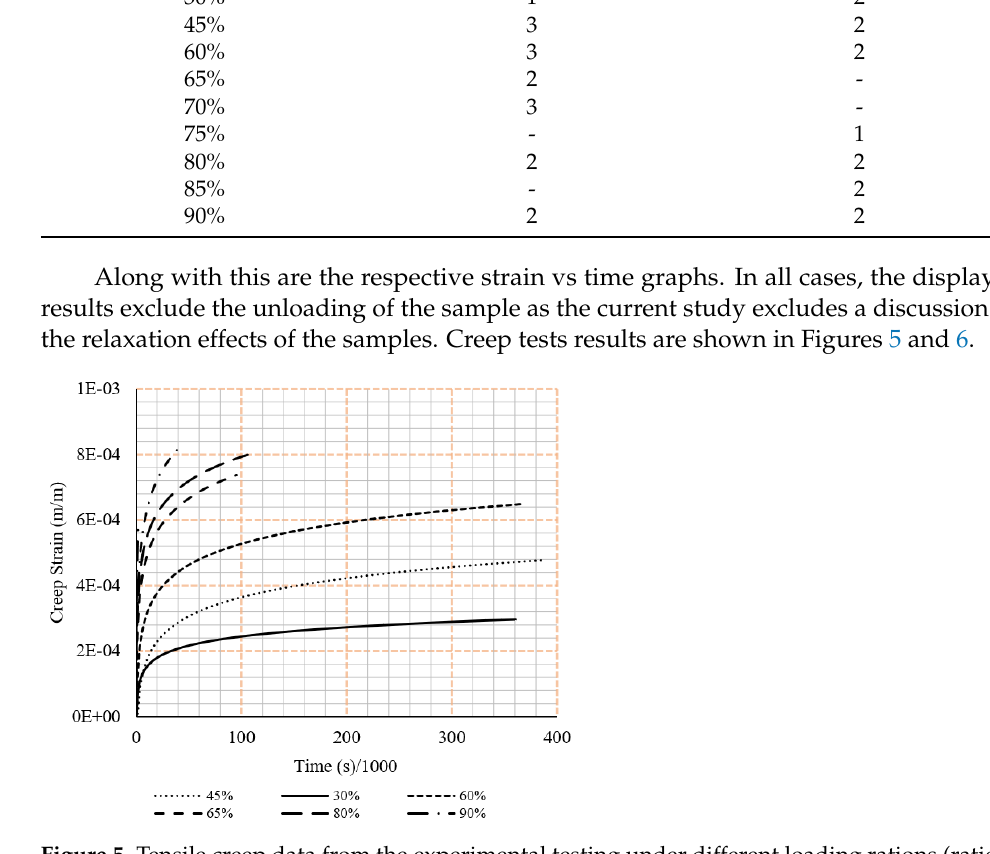
Table 1. Number of tensile samples tested at each force ratio.